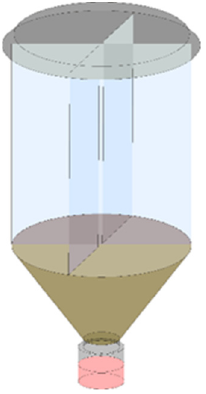
Figure 1. Window flight interception traps.